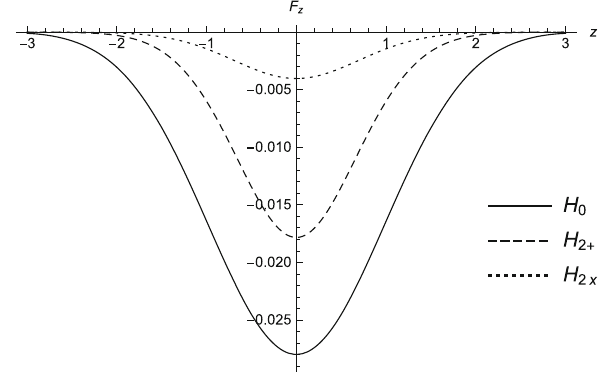
Fig. 5 Forces for solutions (27, 30, 31) with C 0 = 1 / 4, C 2 + = C 2 X = 1, a = 1, t = 0 and f ( u ) = e − u 2 =